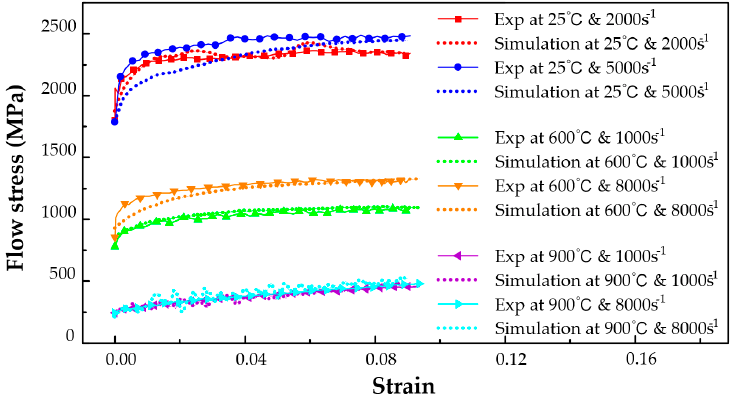
Figure 12. Flow stress-strain curves of SHPB tests and simulation at different strain rate and temperature.